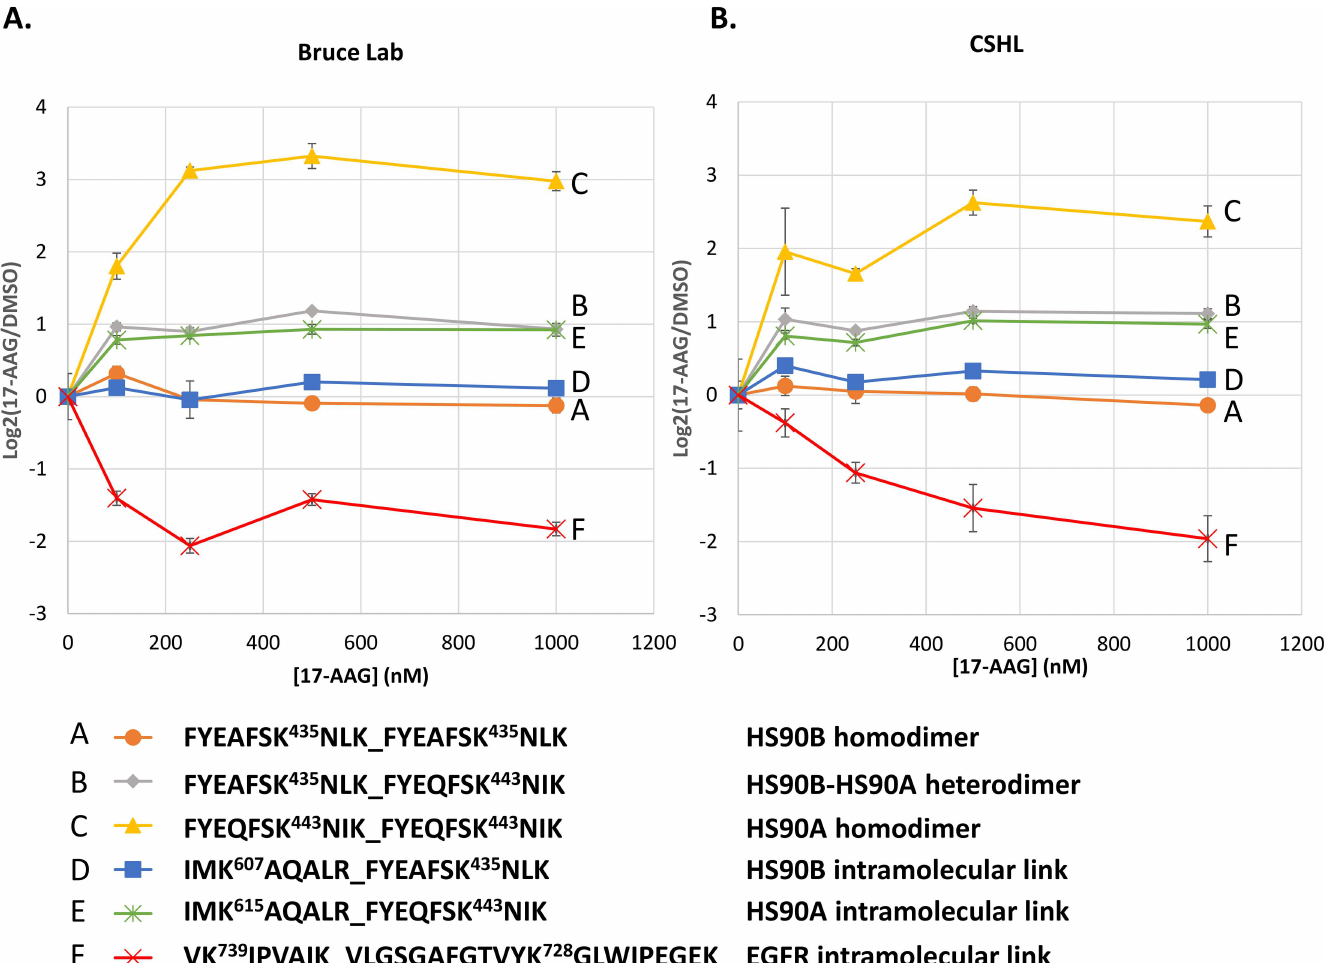
Fig 4. Cross-laboratory quantification of Hsp90 cross-linked peptide pairs. A. Plot of relativelevels of cross-linked peptidepairs versus concentration of 17-AAG as quantifiedby PRM and Skyline in the Bruce Lab. Ratios were normalized to zero for the no drug control sample. B. Plot of relative levels of cross-linkedpeptidepairs versus concentration of 17-AAG as quantifiedby PRM and Skylineat CSHL.